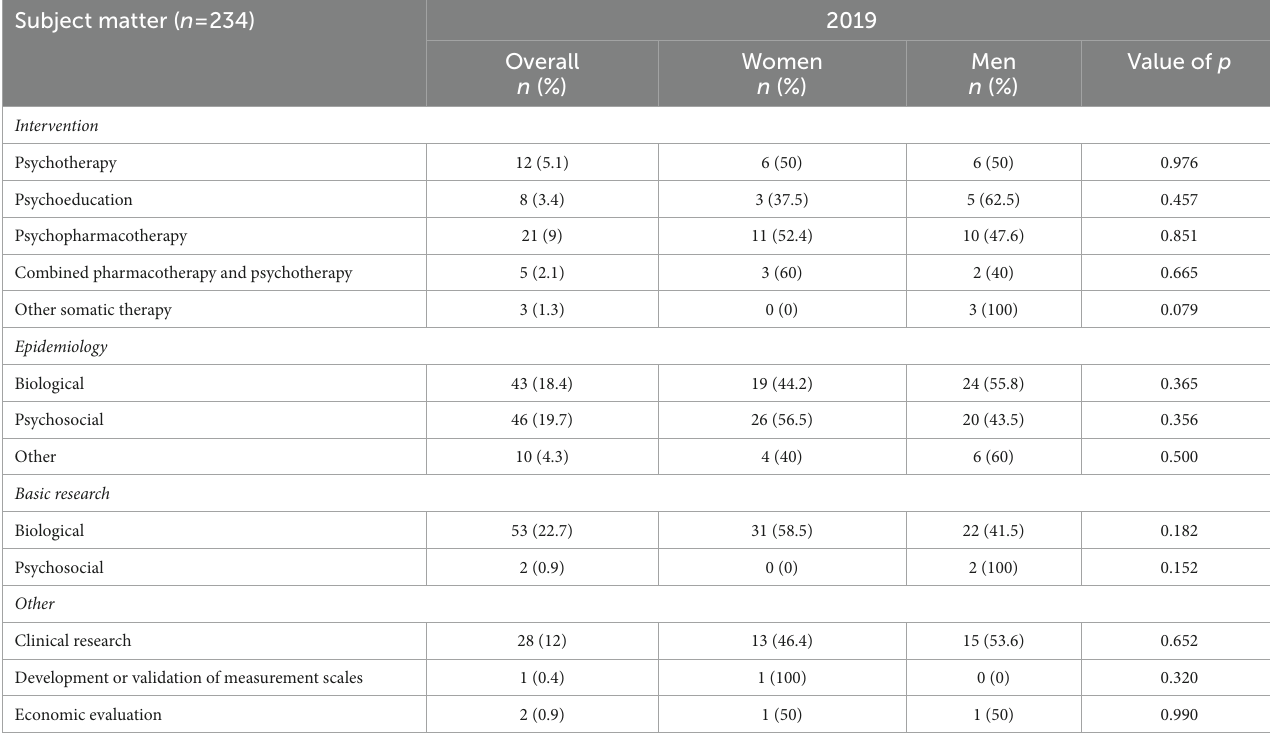
TABLE 3 Number of articles and number of female and male first authors of original research articles by subject matter in